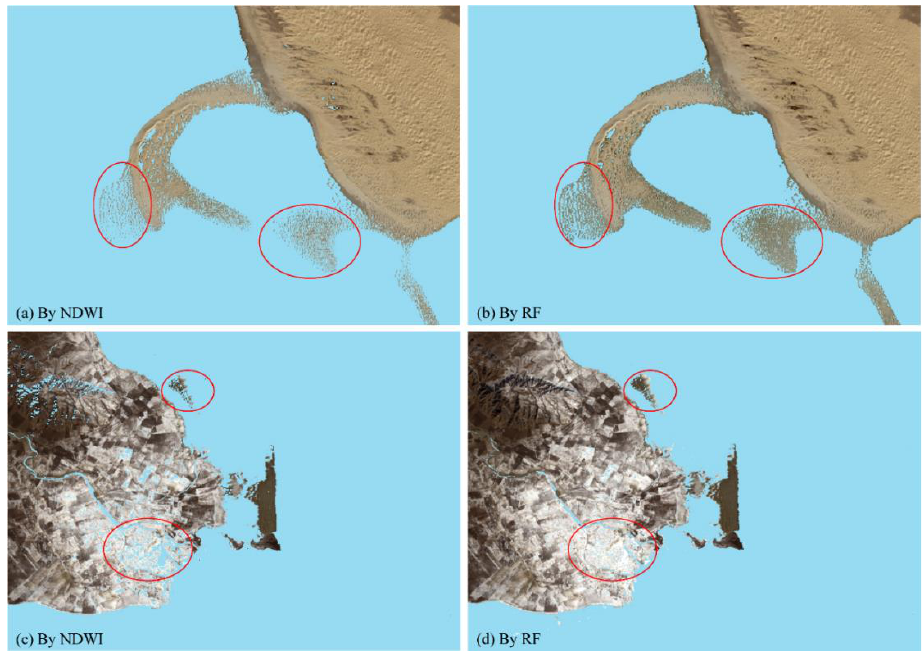
Figure 9. Lake Boundary extraction comparisons between NDWI ( a , c ) and RF ( b , d ).